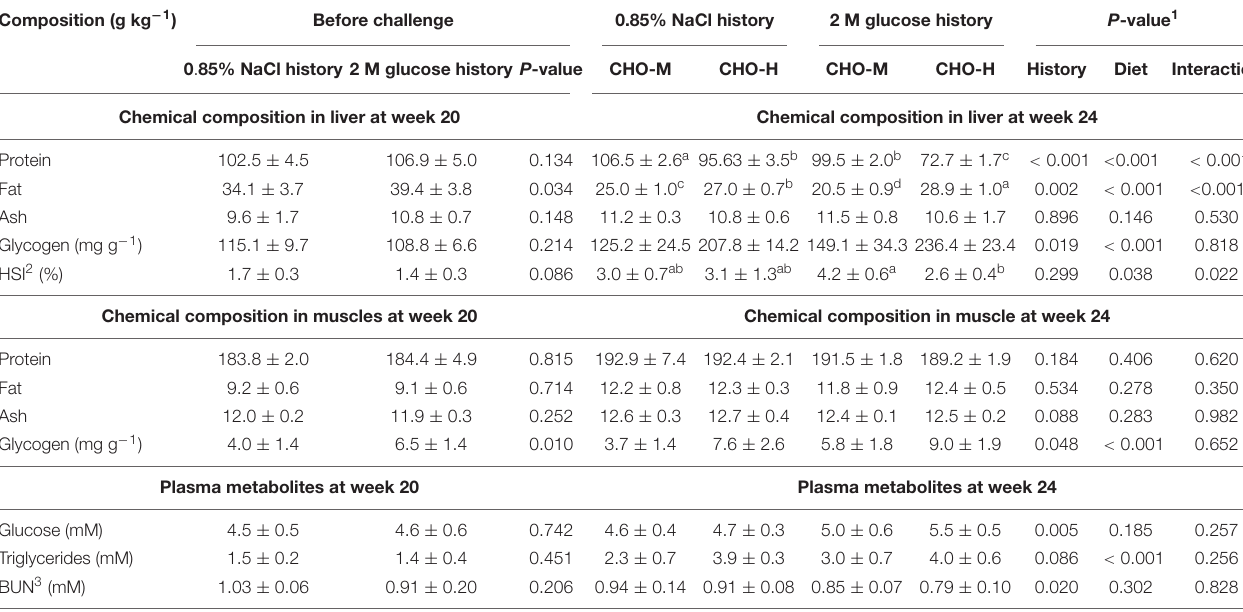
TABLE 3 | Chemical composition and glycogen content in the liver and muscles, HSI and plasma metabolites of fish injected with saline (0.85% NaCl) and glucose (2 M) before (20 wpi) and after (24 wpi) challenging with CHO-M and CHO-H for 4 weeks (mean ± SD, n = 6). Composition (g kg − 1